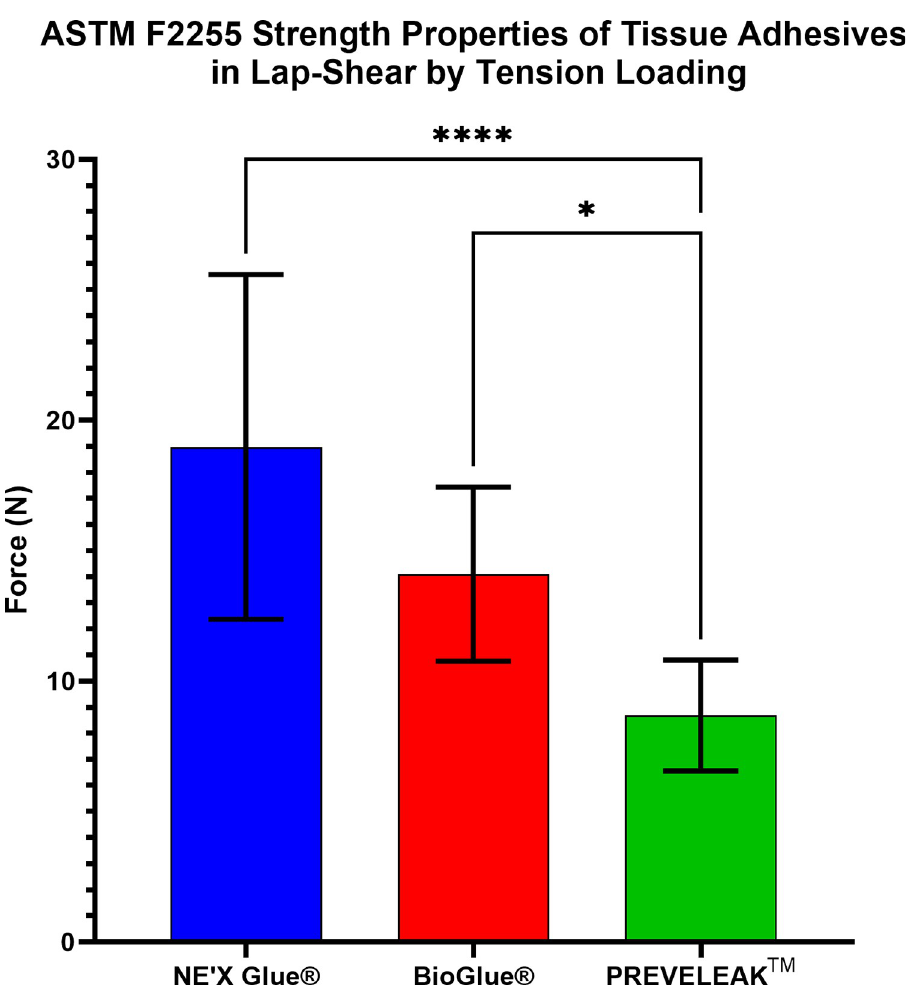
Fig 2. Results of ASTM F2255 strength properties of tissue adhesives in lap-shear by tension loading. n = 10 and p < 0.05 was considered statistically significant.